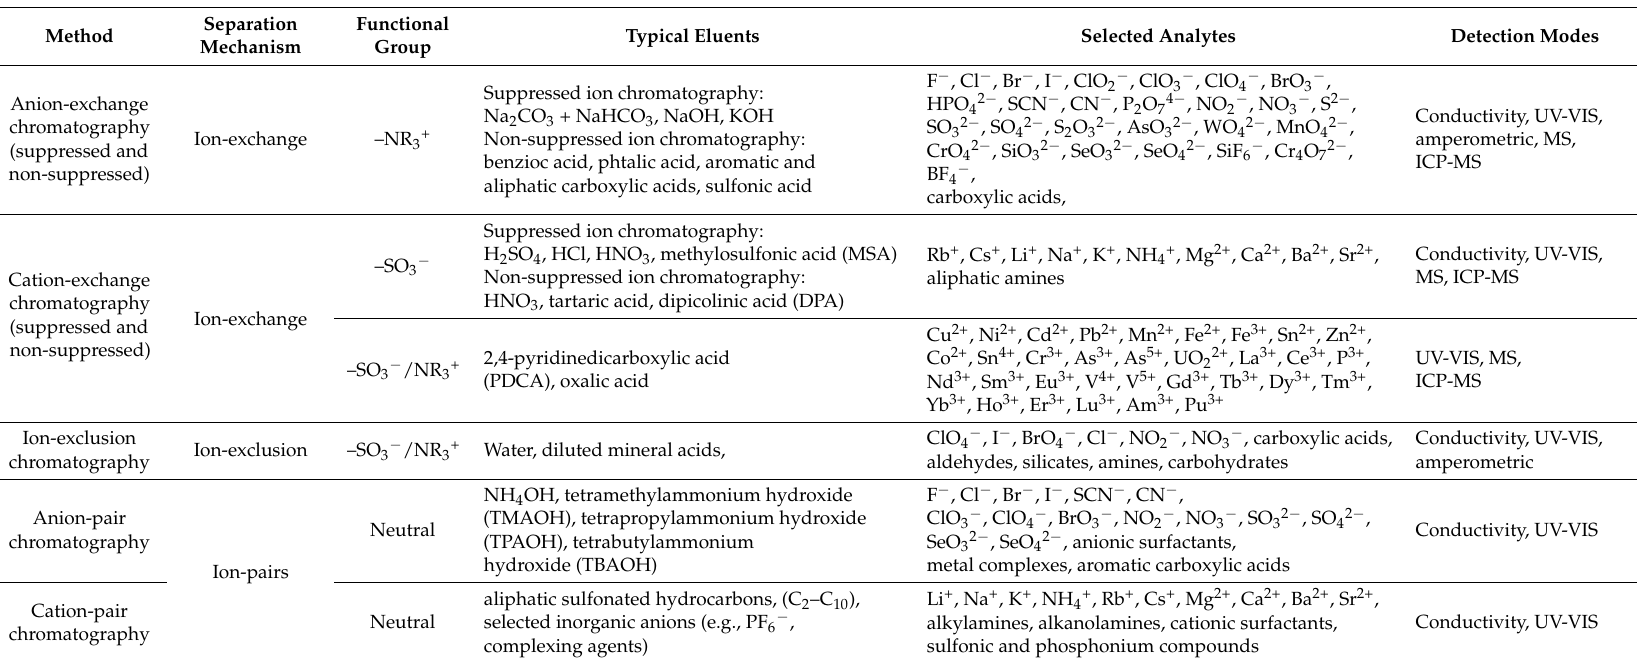
Table 1. Separation methods and their applications in ion